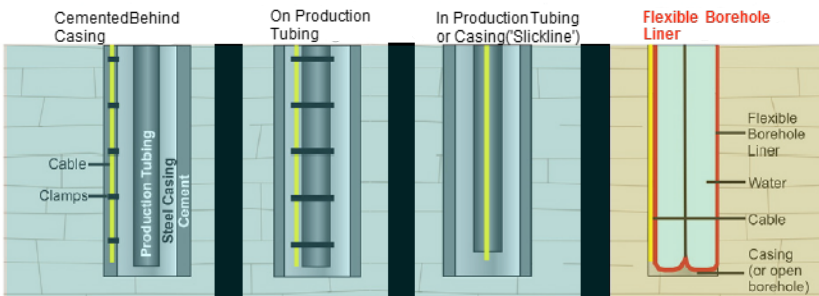
Figure 15. Schematic displaying coupling between the sensing cable and medium for the three conventional and the new flexible liner techniques used for measurements in the borehole. Relative data quality, cost, removability and effective operational depth are compared for these techniques. (Adapted from [64]).